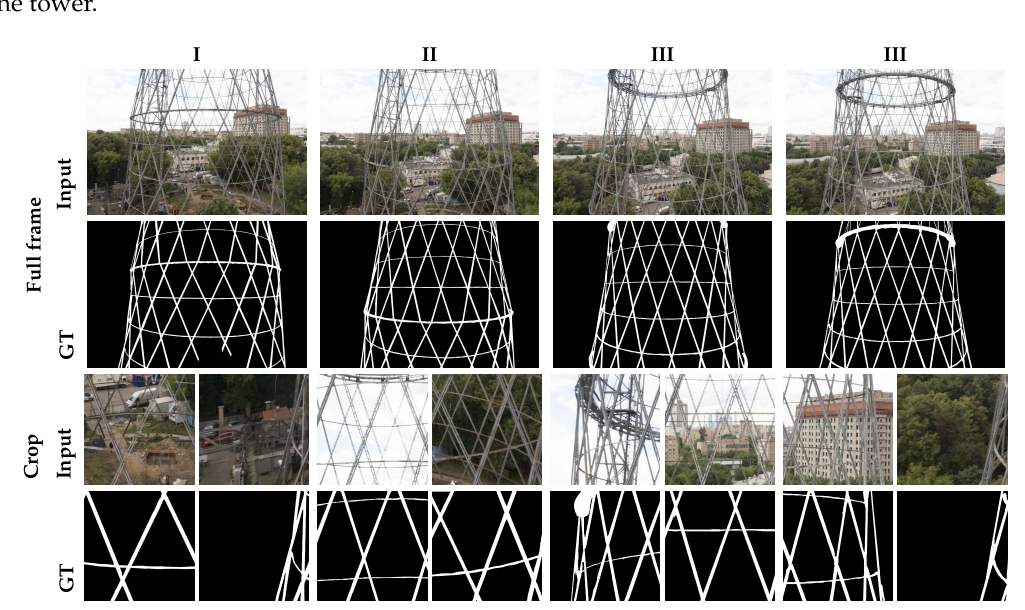
Figure 9. Training dataset:The samples from the paired training dataset containing color images and labelling. Roman numbers indicate various levels of the tower. All images were labeled at the original resolution of 4912 × 3264 pixels. To match the size of the receptive field of the WireNetV2 model, full images were cropped tiles of 1000 × 1000 pixels. Please note that only labeled levels I–IV of the tower from two imaging directions were labeled to perform the segmentation of all levels from all